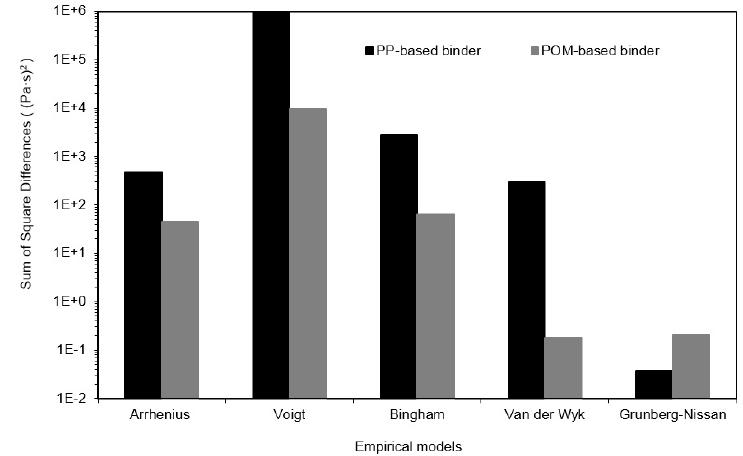
Figure 3. Sum of the square difference for viscosity models fitted to viscosity of PP-based binder measured at 170 °C and POM ‐ based binder measured at 180 °C. Only mixing rules with maximum one fitting parameters and that do not require molecular weight or density data are shown here.